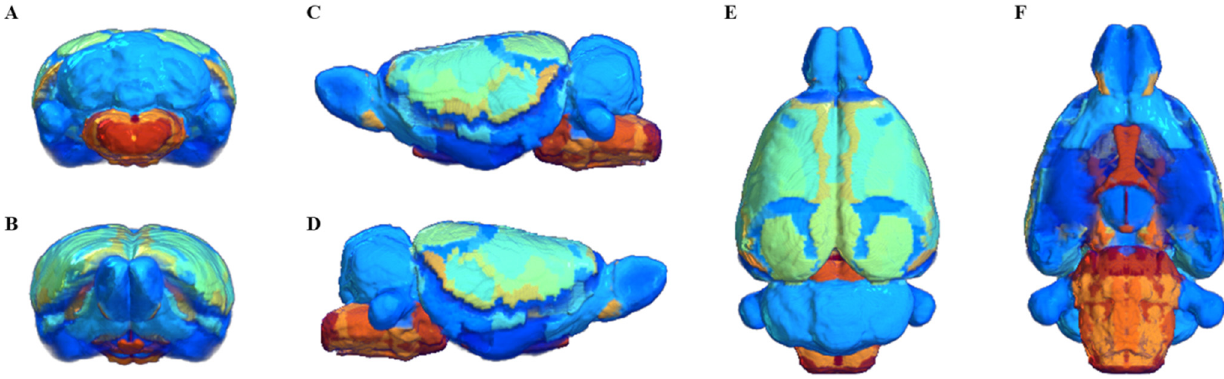
Figure 3. 3D rendering of segmentation and registration results. posterior ( A ), anterior ( B ), left lateral ( C ), right lateral ( D ), superior ( E ), and inferior ( F ). Regions are colored to identify their boundaries, and color similarity between spatially separated regions is meaningless.